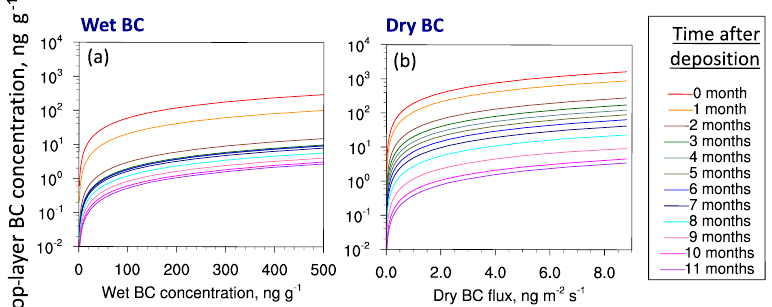
Figure 7. Hydrophilic BC concentration in the top snow layer vs. concentration of BC in precipitation (a) , and hydrophobic BC concen- tration in the top snow layer vs. BC dry deposition flux (b) shown at different times (0–11 months) since deposition. The top-snow-layer concentrations are averaged over the Greenland region, over all the deposition months, and over 10 1-year simulations beginning in the years